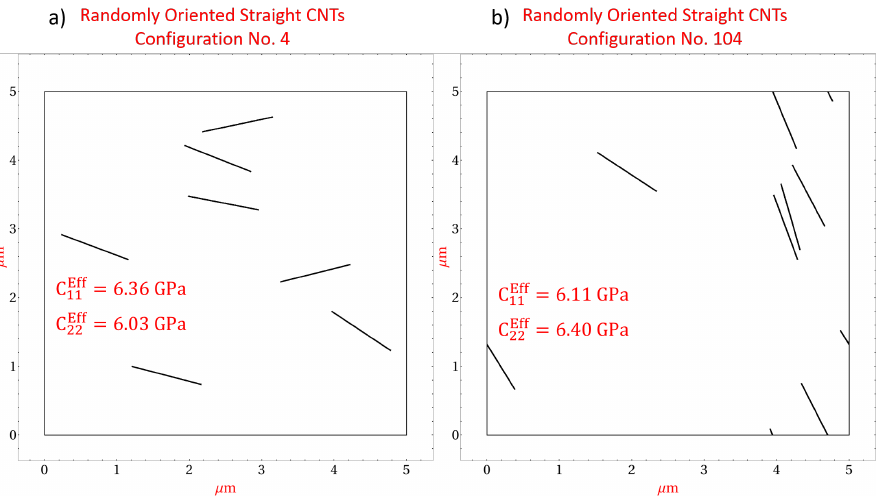
Figure 8. Microscale realizations with straight randomly oriented CNTs at 0.56% CNT volume fraction depicting the effect of CNT orientation on stiffness components C 11 and C 22